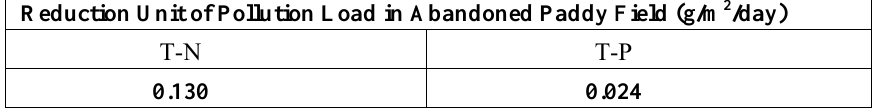
Table 2. Pollution load reduction units of T-N and T-P. The units are drawn from Hosomi et al.